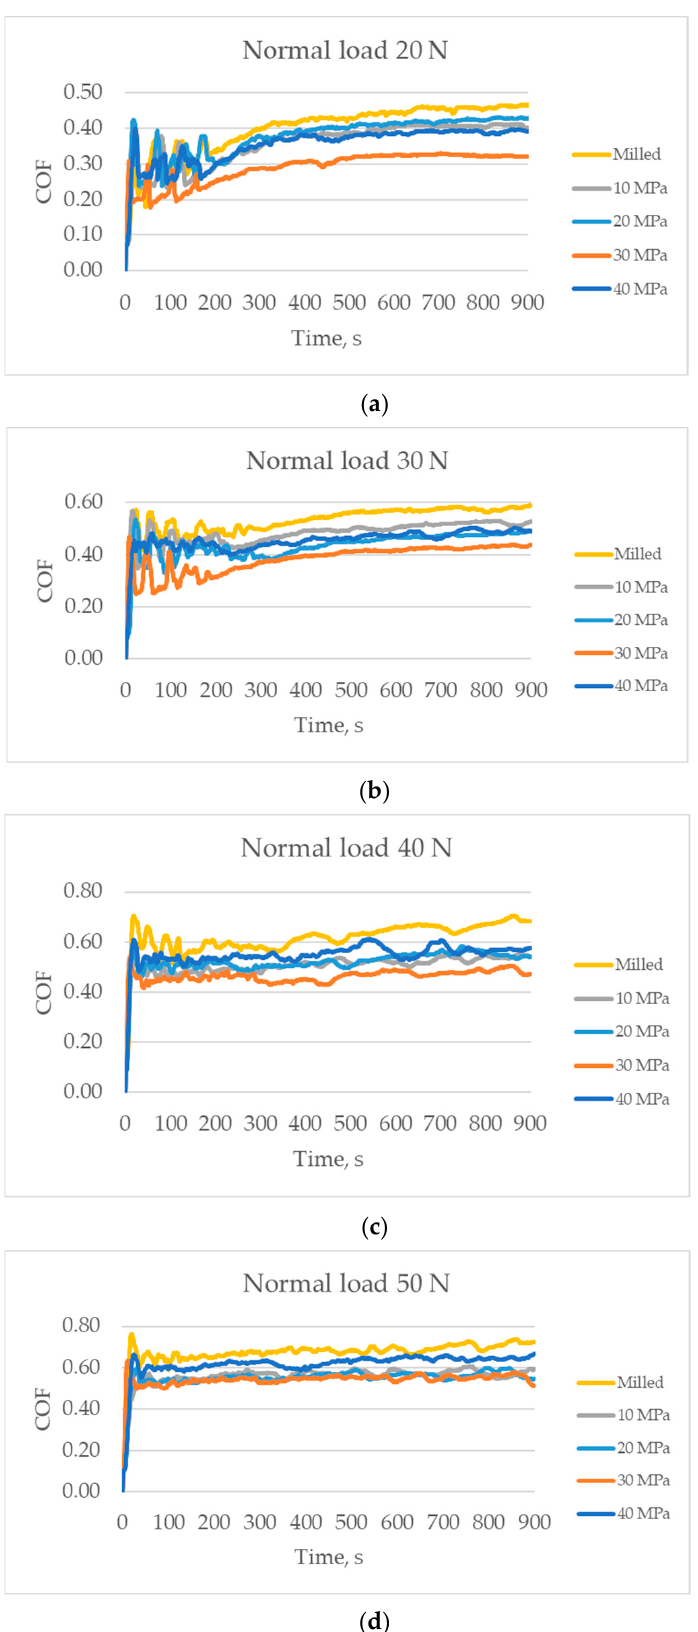
Figure 5. The friction coefficient as a function of time; the normal load was 20 N ( a ), 30 N ( b ), 40 N ( c ), and 50 N ( d ).